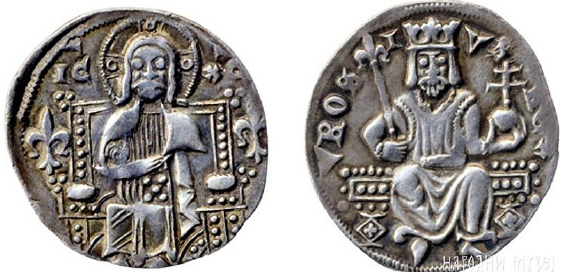
Figure 9. Milutin’s silver dinar, obverse and reverse of silver coin after 1282. Photo courtesy Marina Odak Mihailovi ć .